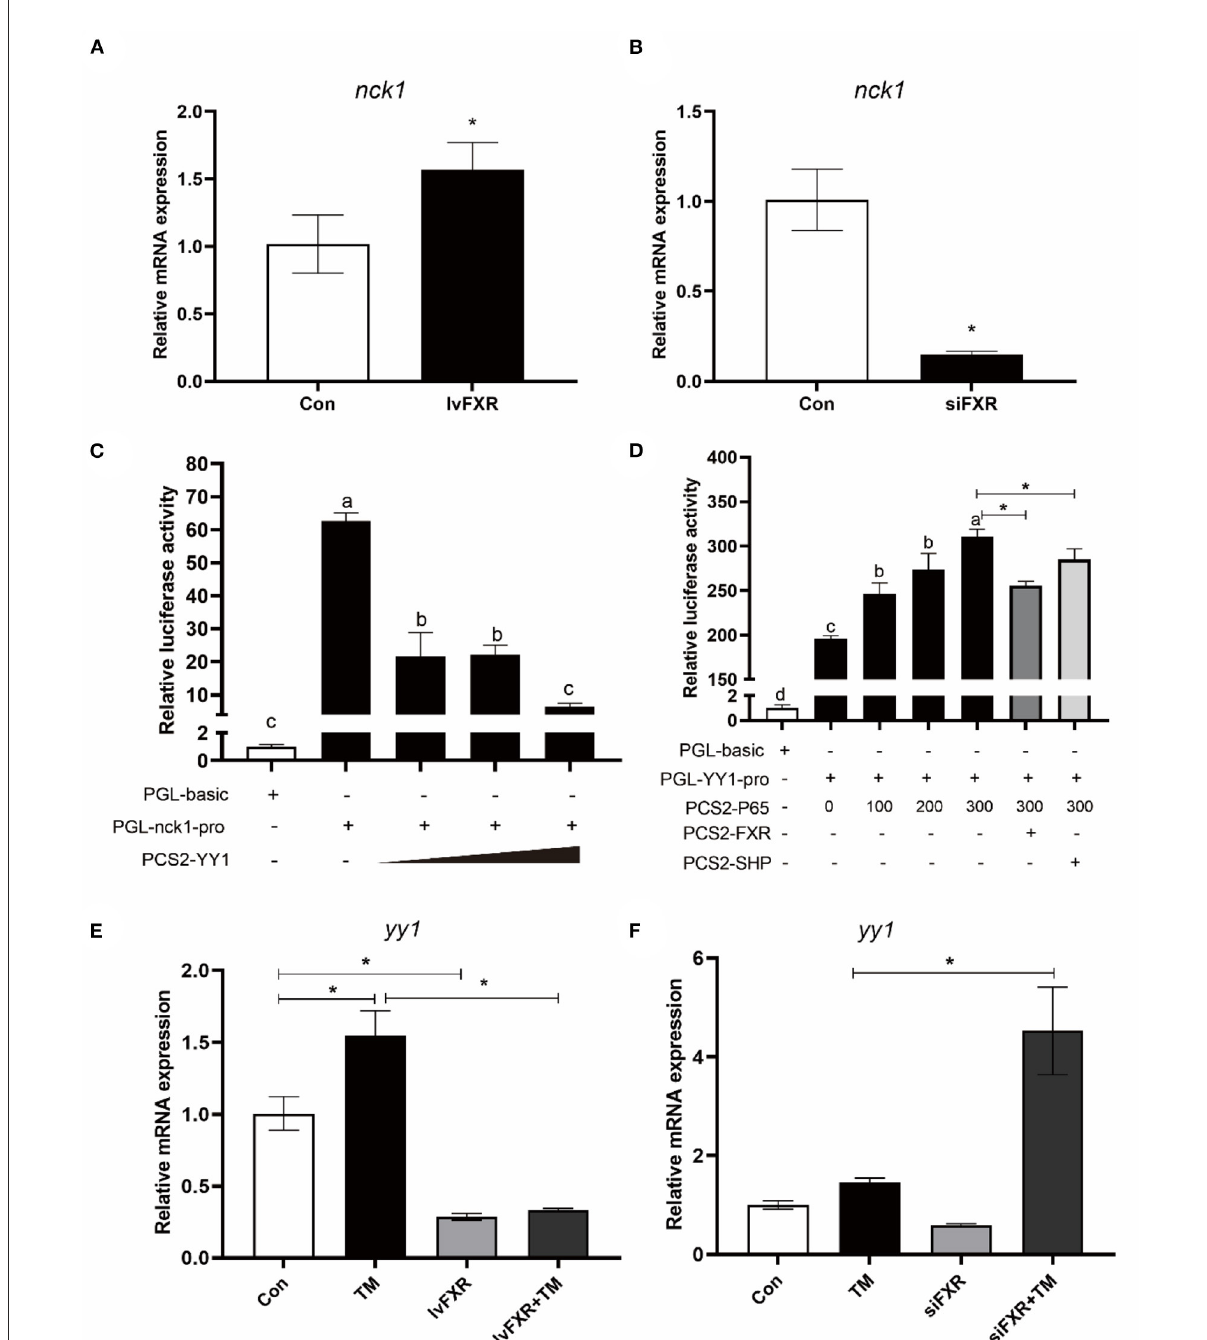
FIGURE8 FXR regulated the expression of NCK1 via YY1. Effects of (A) FXR overexpression or (B) knockdown on NCK1 expression in croaker macrophages. (C) Relative luciferase activities of croaker NCK1 promoter in HEK 293T cells after overexpression of YY1. (D) Relative luciferase activities of croaker YY promoter in HEK 293T cells after overexpression of P65 and FXR. (E,F) Effects of FXR overexpression or knockdown on the TM-induced expression of YY1 in croaker macrophages. The significance was analyzed by one-factor ANOVA and Duncan’s Multiple Range Test (means ± SEMs; n = 3). Means without the same label were considered different, P < 0.05. *Different between two groups (Student’s t